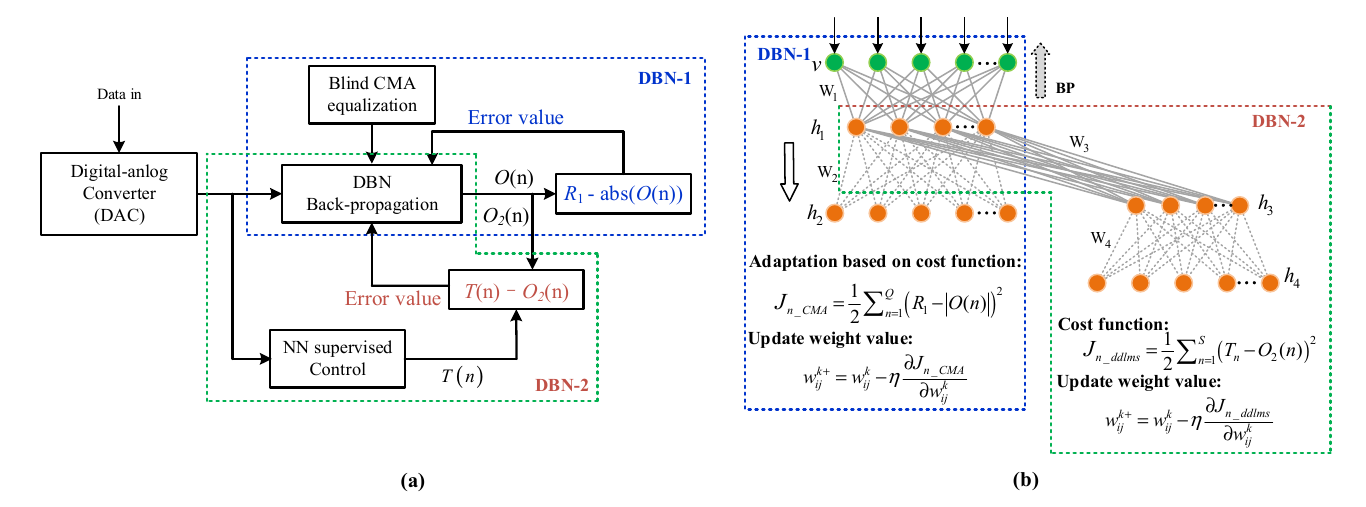
Figure 2. The proposed J-DBN equalizers: ( a ) schematic diagram; ( b ) architecture.